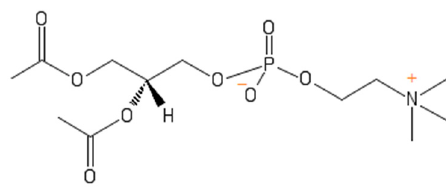
Figure 2. General structure of a PC.